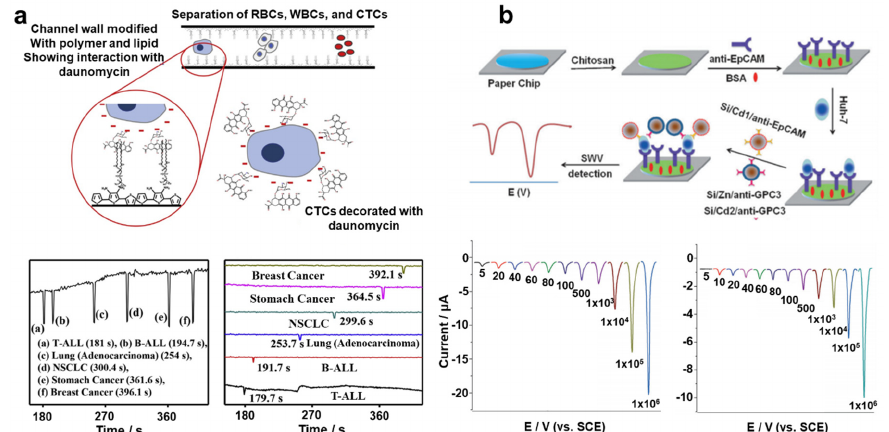
Figure 6. ( a ) Schematic images detailing the process of CTC capture using a functional channel wall and separation of target CTCs in mixed cancer cell samples. This figure is reproduced from [93] (© 2019 Elsevier B.V.); ( b ) Schematic image showing the fabrication and capture process of a paper-based microfluidic immunodevice and electrochemical signals obtained from CTCs detected in various concentrations. This figure is reproduced from [94] (© 2014 John Wiley &